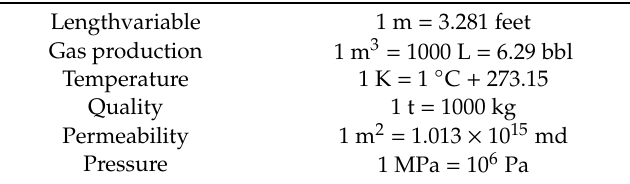
Table 3. Common unit conversion table.